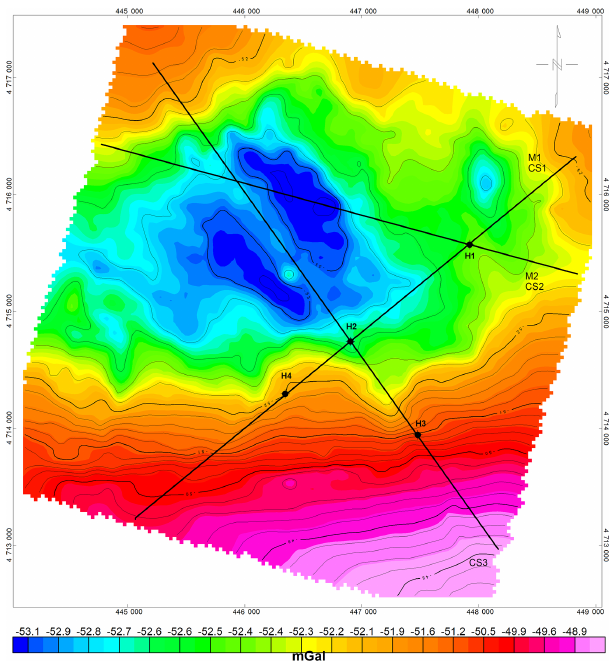
Figure 3. Complete Bouguer anomaly map of the Hontomín area calculated with a reduction density of 2400kgm − 3 . Black dots mark the position of well data. Black lines represent the position of 2-D models 1 and 2 and cross sections (CS) 1–3 (Fig. 6) extracted from the final 3-D model (Fig.